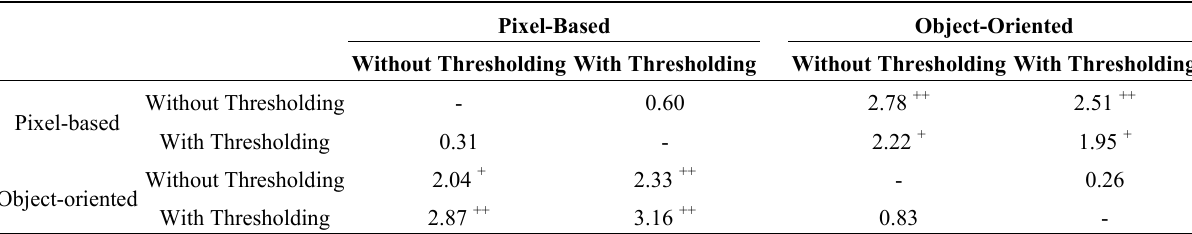
Table 4. Pairwise Z-score test of the effect of pixel-based vs. object-oriented methods and shadow thresholding on the accuracy of shadow detection (lower left) and overall image classification (upper right).